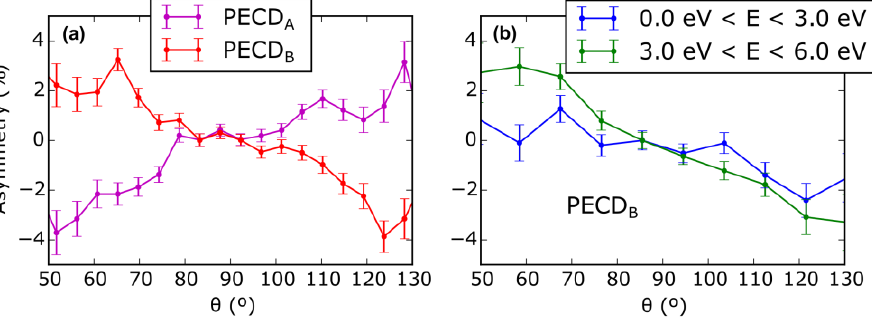
Fig. 2. (a) Measured PECD asymmetry as defined in Eq. (1) as a ratio of the yield of electrons for sample S and R. θ is the angle between the momentum o f the electron and the laser propagation direction. PECD asymmetry inverts sign when helicity of laser is changed. (b) PECD for the case of helicity B plotted for two different photoelectron energy